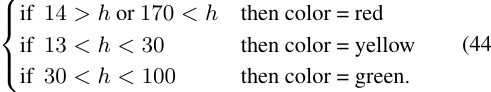
The results of the red, yellow, and green objects are shown in Figure 3. However the traffic light lenses are red, yellow, and green, these colors may be shifted in the image. For instance, the green color of the traffic light may be seen as light blue and there- fore, the thresholds in (44) are designed in a way that it includes other possible colors of the traffic lights such as light blue. The sky in Figure 3 is chosen as green object for the same reason. In addition, the boundary between red and yellow colors is ambigu- ous and the red traffic light lenses may be seen as dark yellow lenses and vice versa. Therefore, the red and yellow colors have an overlap in hue.